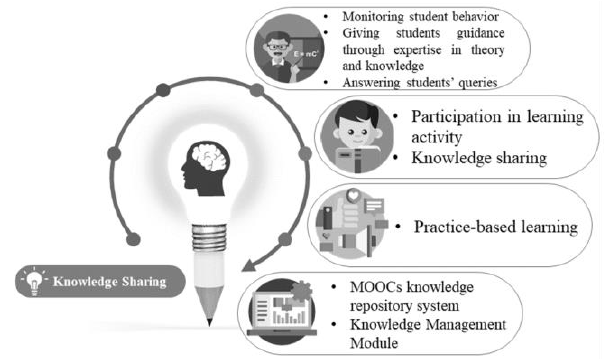
Fig. 8. Knowledge